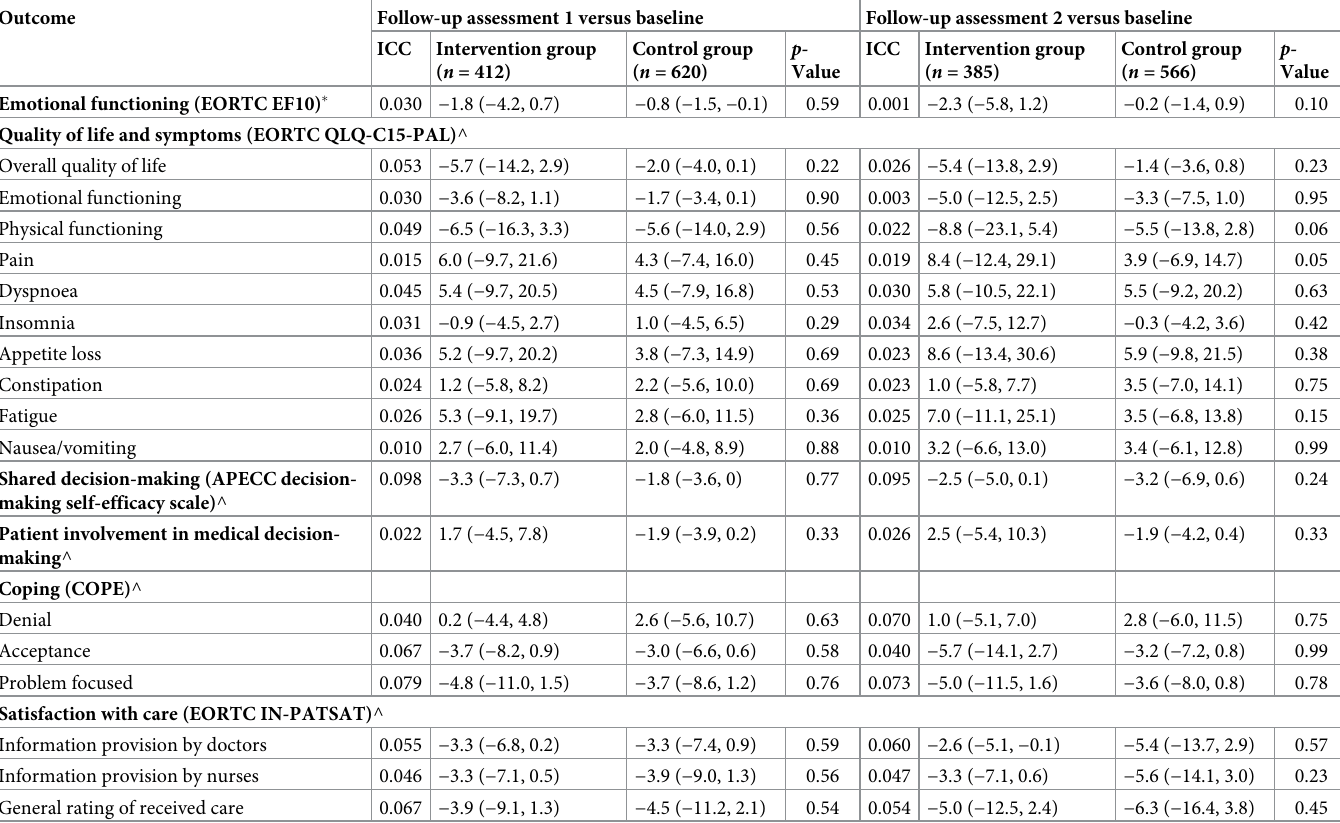
Table 2. ICC and changes in outcome scores between follow-up assessment 1 and baseline and follow-up assessment 2 and baseline (with 95% confidence intervals), with p -values from multilevel regression model with random intercept and with hospital as random level adjusting for baseline levels of each